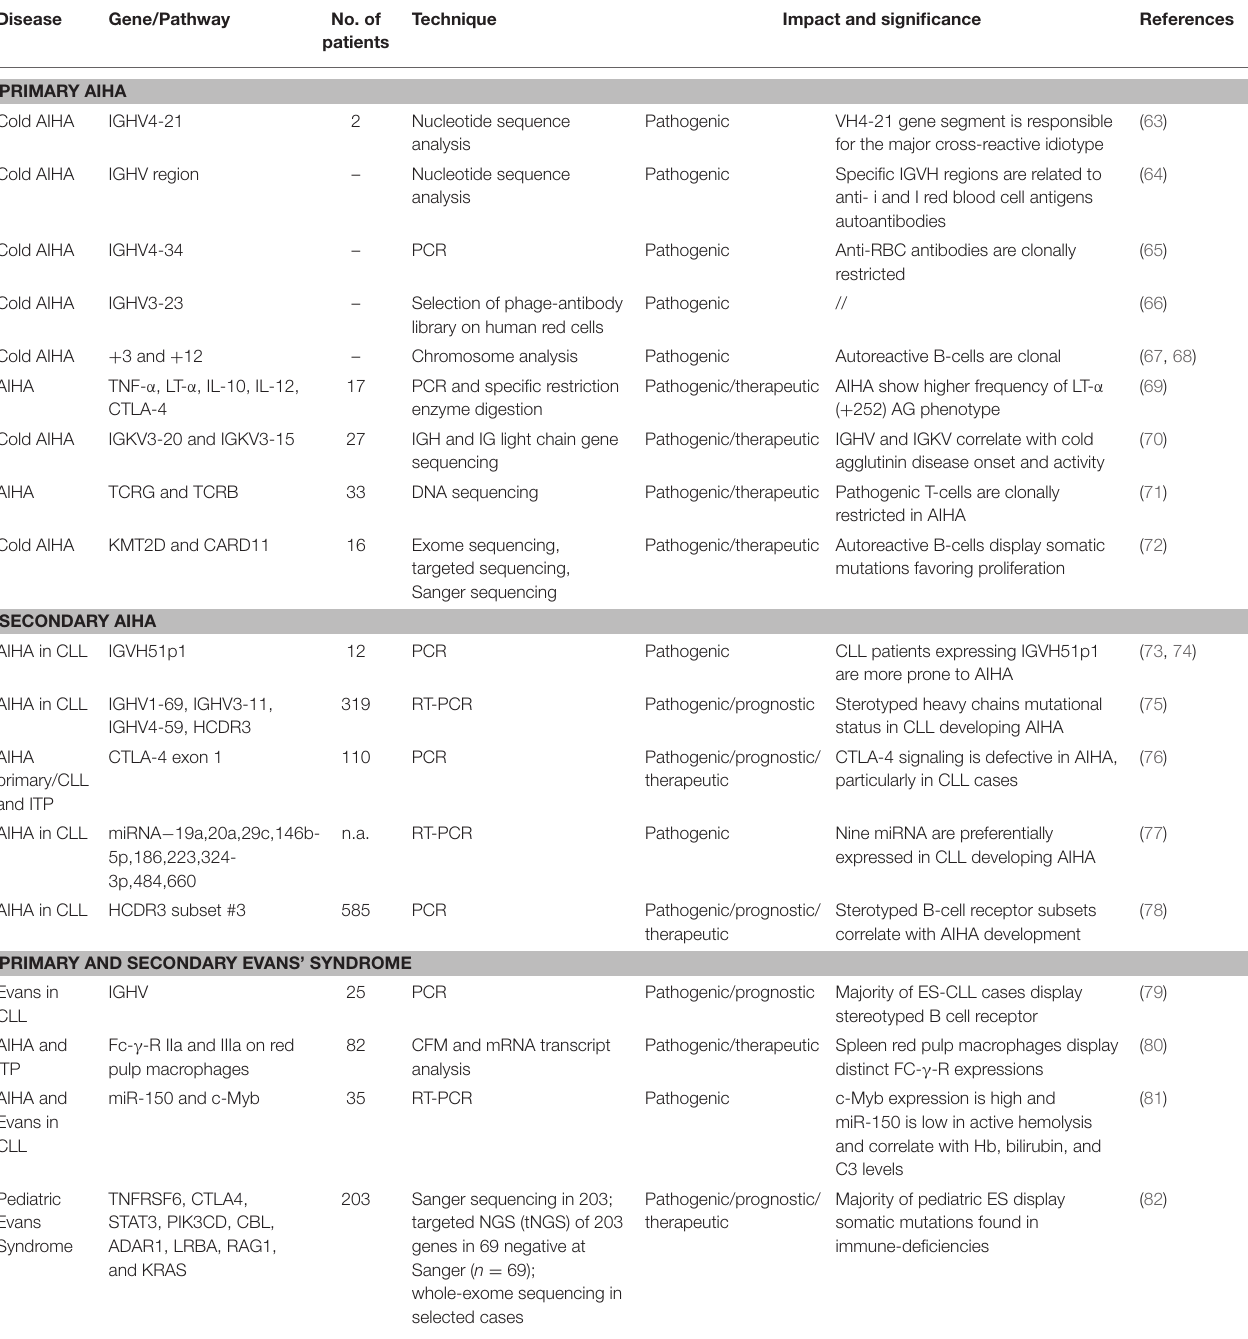
TABLE 2 | Molecular findings in primary and secondary autoimmune hemolytic anemia (AIHA) and Evans’ syndrome.